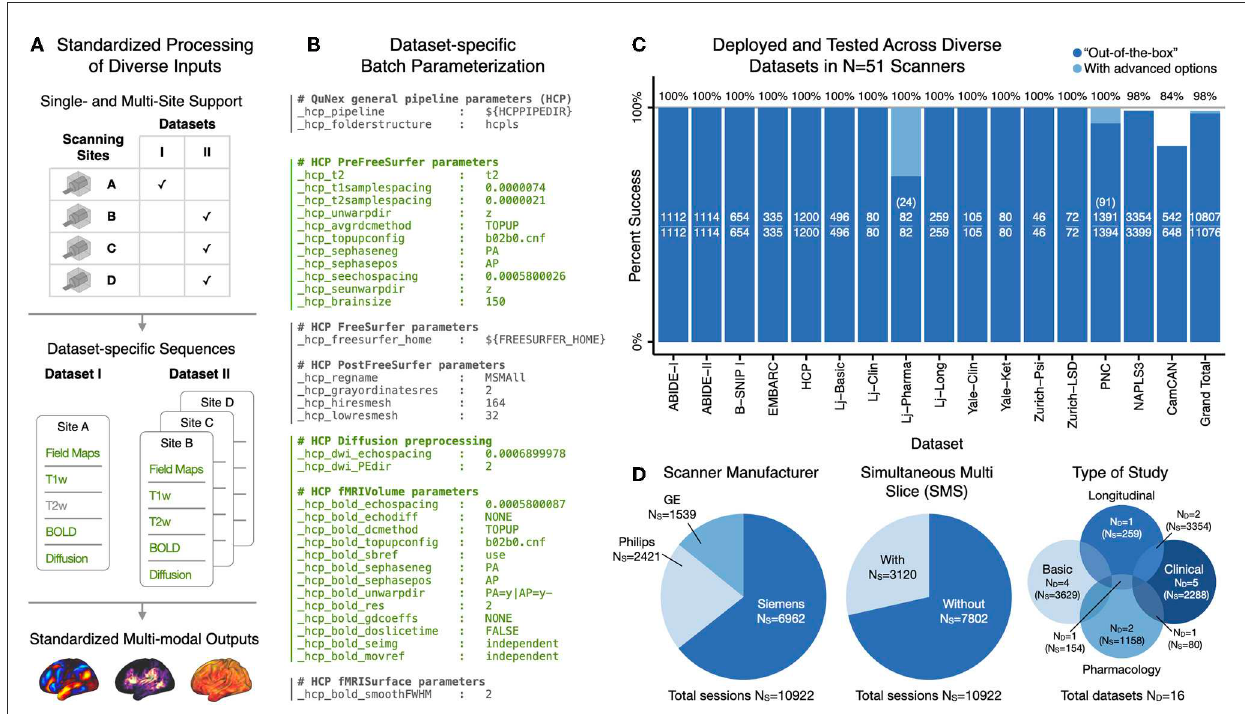
FIGURE3 Consistent processing at scale and standardized outputs through batch specification. (A) The batch specification mechanism in QuNex is designed to support data processing from single-site and multi-site datasets to produce standardized outputs. Acquisition parameters can be flexibly specified for each sequence. Here, example datasets I (single-site study) and II (multi-site study) illustrate possible use cases, with the sequences in each dataset shown in green text. Although Dataset I does not include T2w scans, and Dataset II contains data from different scanners, all these data can be consistently preprocessed in all modalities to produce standardized output neural features. (B) Parameters can be tailored for each study in the header of the batch processing file. An example is shown with parameters in green text tailored to Site B in Dataset II (similar to those used in HCP datasets; Glasser et al., 2013). Detailed instructions and examples for setting up the batch parameter header for a user’s specific study is available in the documentation. (C) QuNex has been highly successful in preprocessing data from numerous publicly available as well as private datasets, totalling over 10,000 independent scan sessions from over 50 different scanners. In some cases, advanced user options can be used to rescue sessions which failed with “out-of-the-box” default preprocessing options. These options include using custom brain masks, control points, or